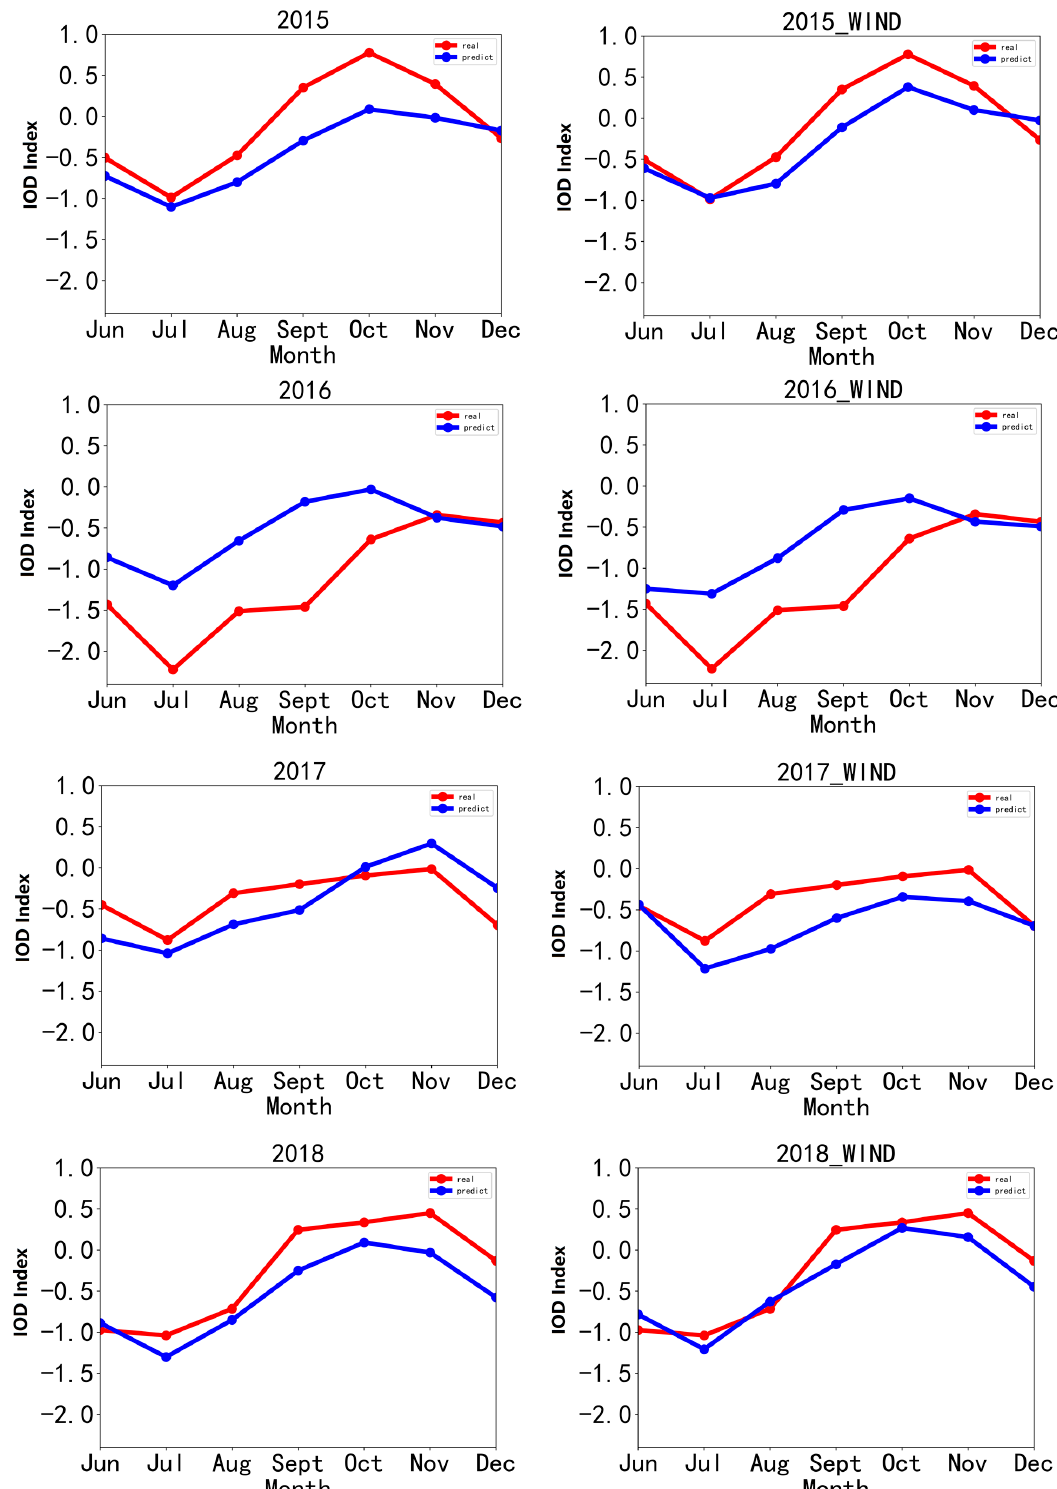
Figure 4. The IOD index of the convLSTM model without wind field data and the index of the convLSTM model with wind field data from 2015 to 2018.